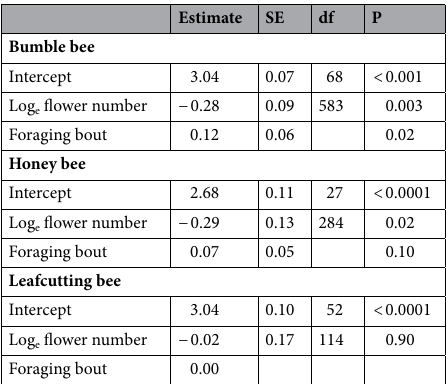
Table 3. Distance model for each bee species the second year. The variable SE represents the standard error of the estimate, df is the degree of freedom, and P, the probability. Foraging bout is a random variable and flower number a fixed effect in the model.